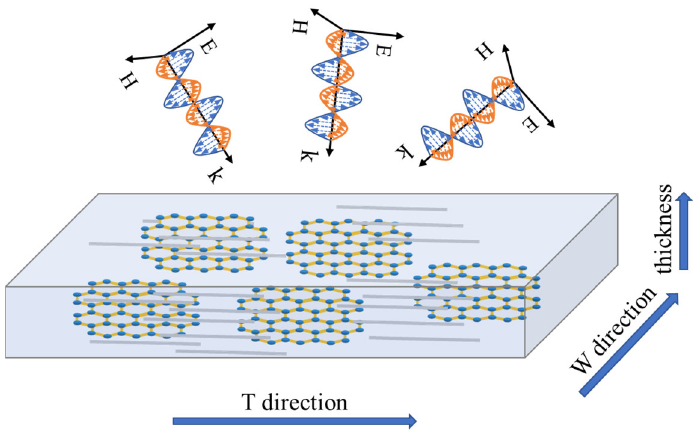
Figure 9. Schematic diagram of material